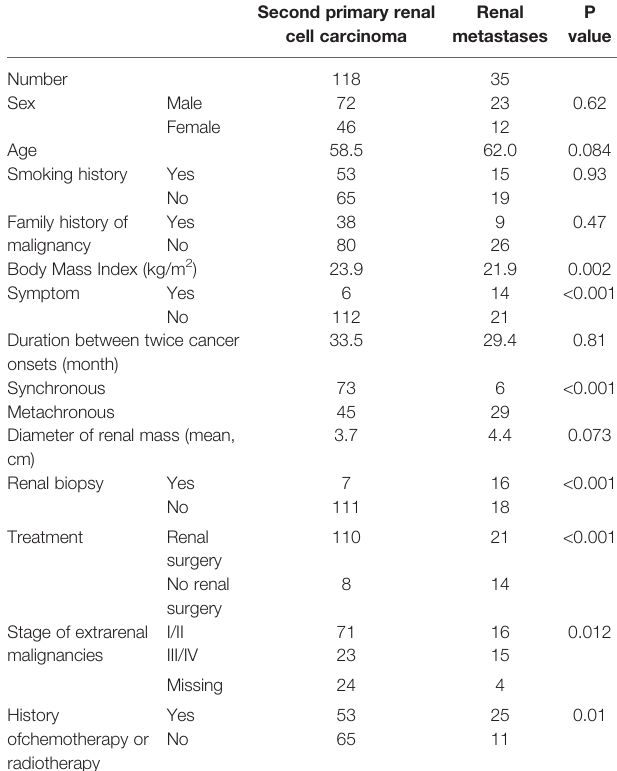
TABLE 1 | Demographics and clinical characteristics of patients with second primary renal cell carcinoma and with those of renal